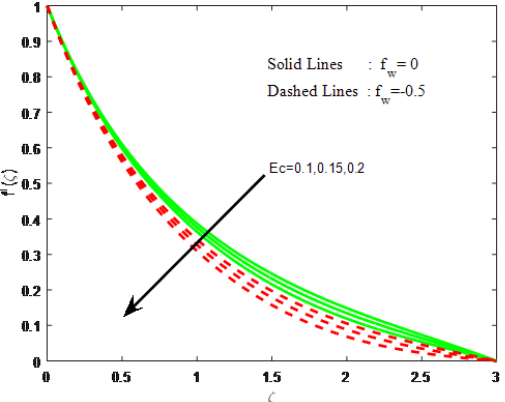
Fig. 8: The effect of Eckert number Ec on velocity field profile